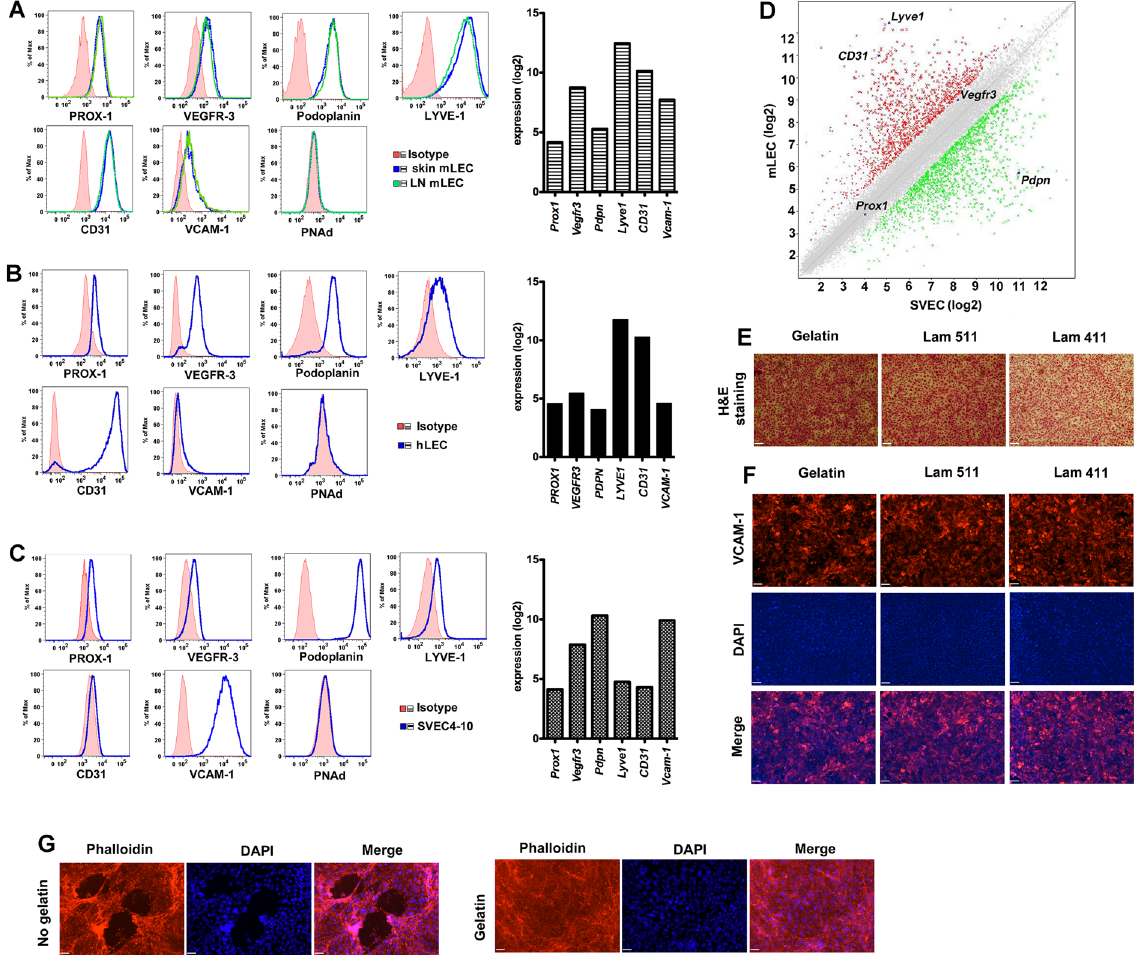
Figure 1. Characterization of LEC with flow cytometry and gene array. ( A ) Mouse skin or lymph node primary mLEC, ( B ) human skin primary hLEC, or ( C ) SVEC4-10 stained for the indicated markers and Affymetrix gene array. ( D ) Affymetrix gene array analyzed with GeneChip ® Command Console ® Software (AGCC) and Transcriptome Analysis Console (TAC) for SVEC4-10 vs mouse LEC. ( E ) H&E staining of SVEC4-10 layers grown on inserts coated with gelatin, laminin 411 and laminin 511, x10, scale bar 80 μ m. ( F ) Fluorescence staining of SVEC4-10 layers for VCAM-1 with inserts coated with gelatin, laminin α 4 β 1 γ 1 and laminin α 5 β 1 γ 1, x10, scale bar 80 μ m. ( G ) Fluorescence staining of phalloidin and DAPI for SVEC with inserts coated with/ without gelatin. Representative of three independent experiments, triplicates for gene array, x10, scale bar 80 μ m * P <